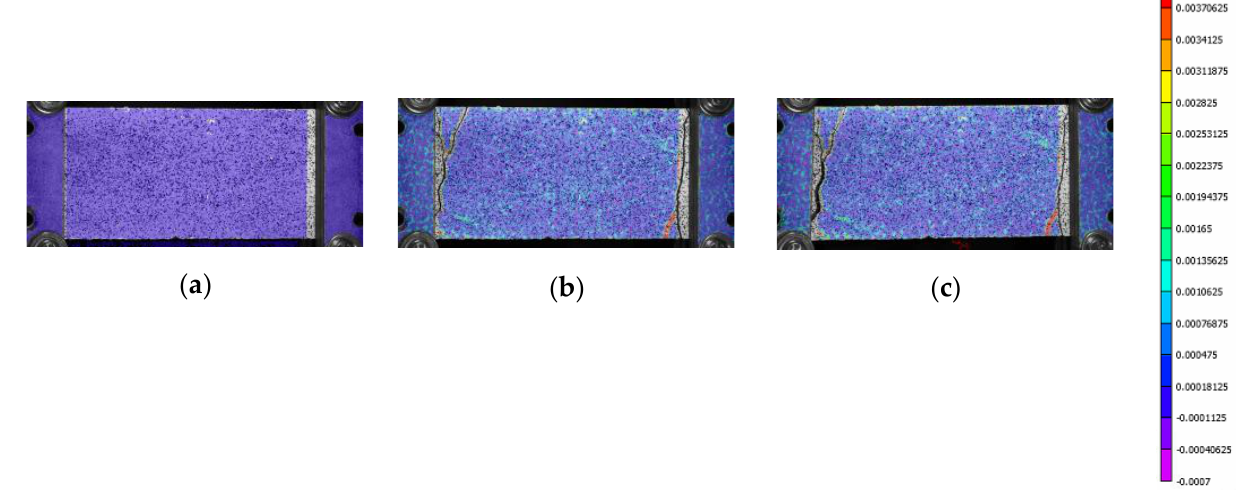
Figure 6. Pictures of specimen BP-2-A at the beginning of the test ( a ), maximum load ( b ) and after the drop in load ( c ). The color scale represents the grade of the major principal strains, from 0.004 units in red to − 0.0007 units in purple.